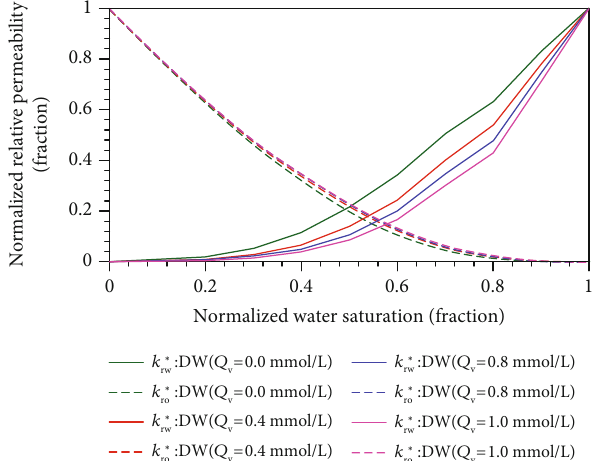
Figure 4: Normalized oil-water relative permeability curves under di ff erent Q v .